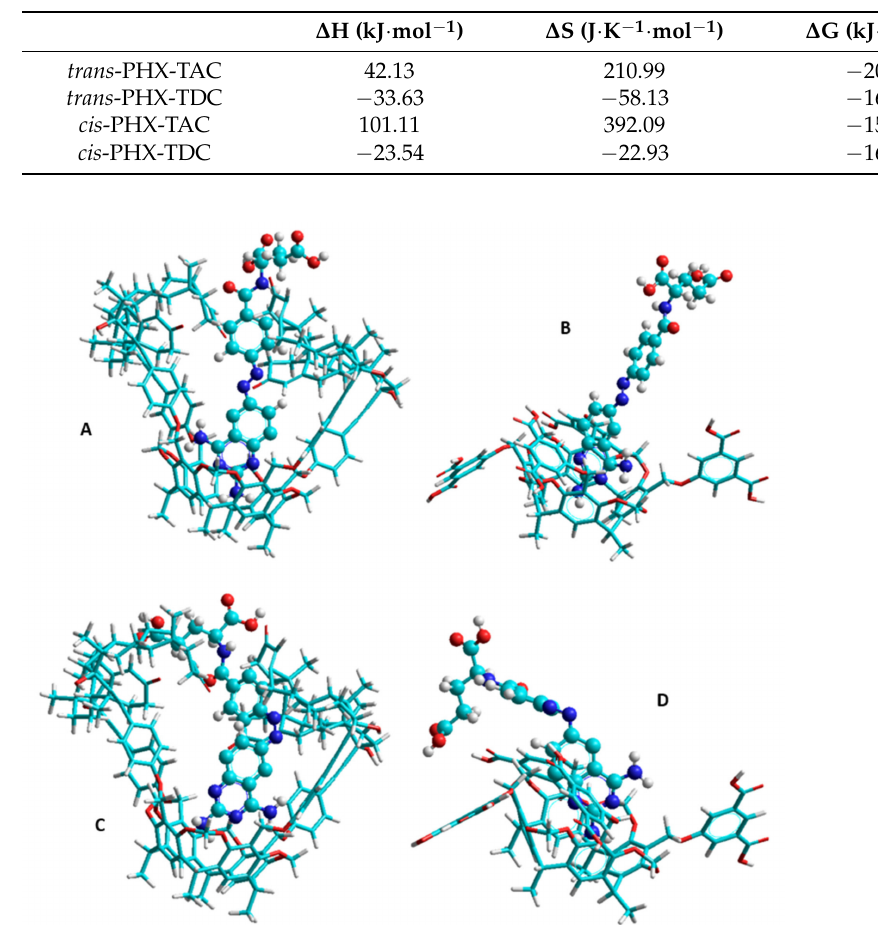
Figure 6. The 3D structures of the complexes of trans -PHX with TAC ( A ), trans -PHX with TDC ( B ), cis -PHX with TAC ( C ) and cis -PHX with TDC ( D ) calculated at AM1 level using the TIP3P solvation model. Solvent molecules are omitted due to the